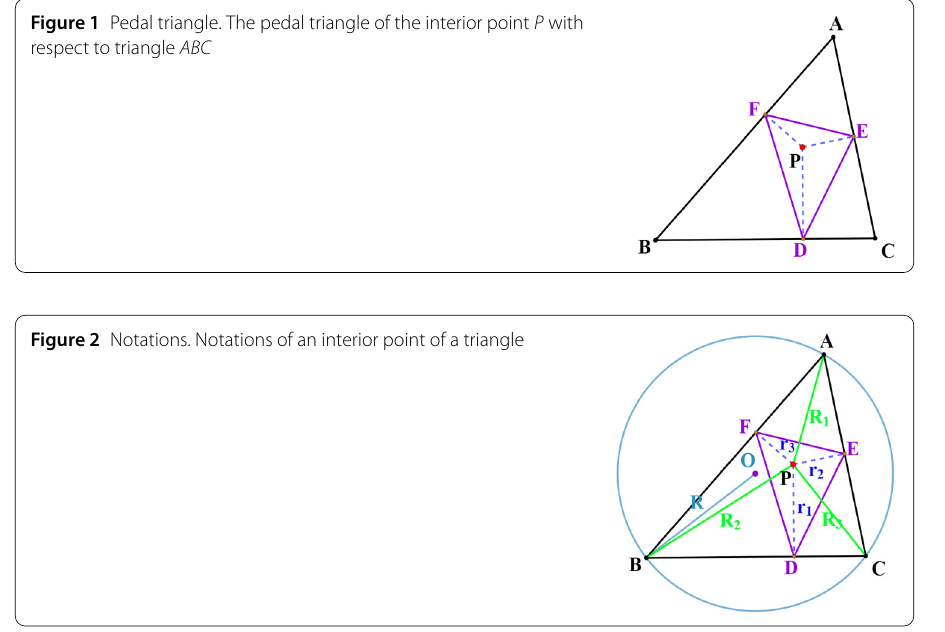
Figure 2 Notations. Notations of an interior point of a